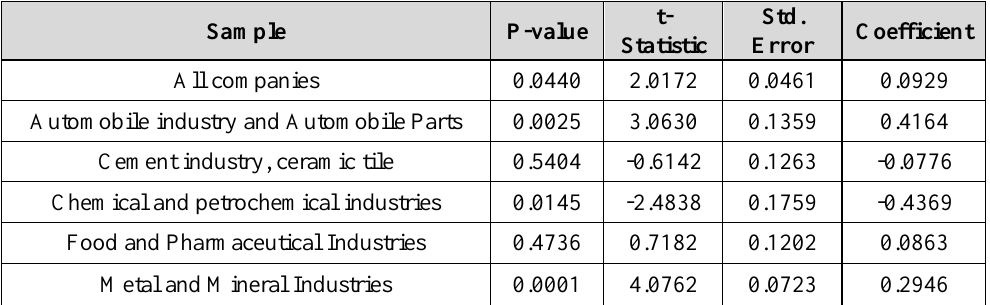
Table 6. Results of the Growth stage and capital investment choice in the type of